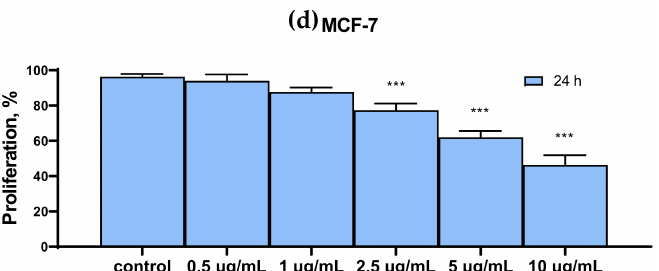
Figure 2. MTT cell proliferation assay of intact cells and SeNP-treated cells for 24 h ( a )—A-172; ( b )—Caco-2; ( c )—Du-145; ( d )—MCF-7. Data are expressed as percentage of control (intact cells; set to 100). Each value is the mean ± SD ( n ≥ 3, p < 0.05). One-way ANOVA with Sidak’s multiple comparisons test. Comparison with control, *** p -level < 0.001.